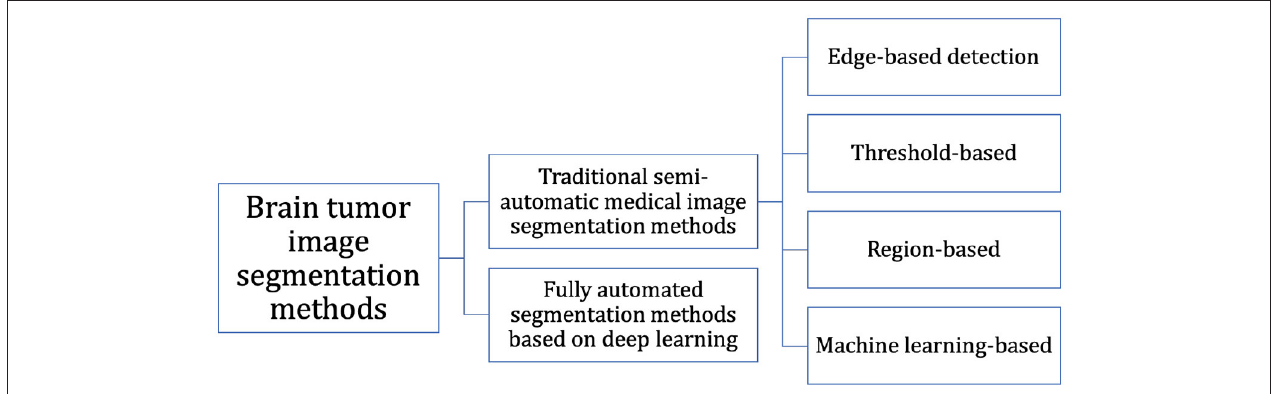
FIGURE 1 | Classification of brain tumor image segmentation